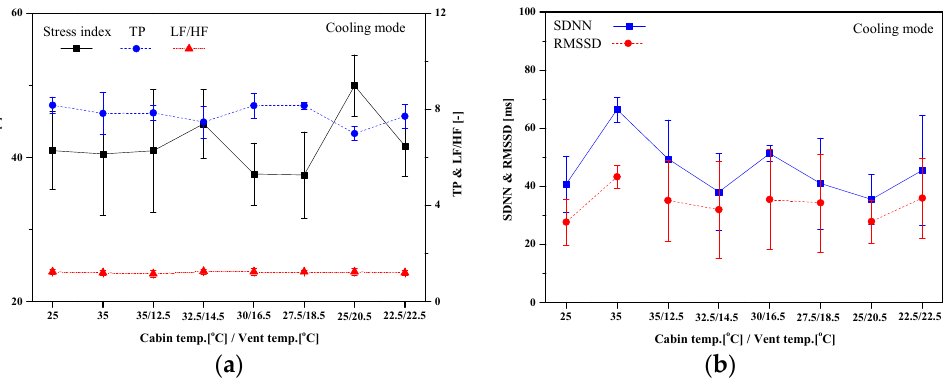
Figure 9. Variations in driver’s PPG in cooling condition. ( a ) stress index, total power (TP), and LF/HF; ( b ) the standard deviation of N-N interval (SDNN) and root mean square of successive differences (RMSSD).